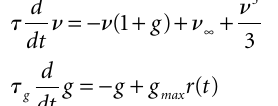
), and a spike-frequency adaptation LPF (green, M R1 − 3